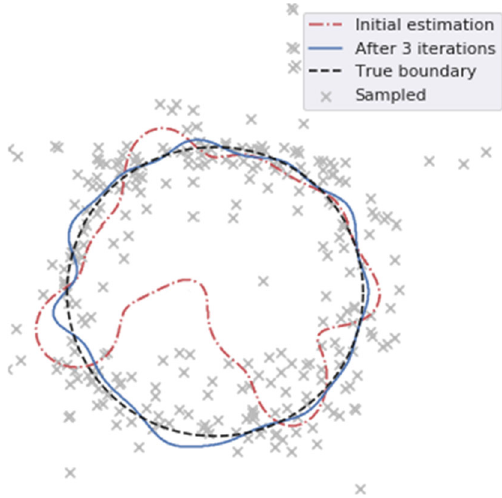
Fig. 1 With active learning new data points can be sampled in regions ofinterest,likeforexampleadecisionboundaryinaclassificationprob- lem.Thefigureshowshowtheinitialestimation(dashed-dottedredline) of the decision boundary (dashed black line) is located at the location where the classification of new points is most uncertain. By iteratively sampling new points (crosses) in this most uncertain region and deter- mining a new estimation of the decision boundary, the estimation of the boundary will get increasingly more accurate, as can be seen in the picture for 3 iterations (solid blue line)